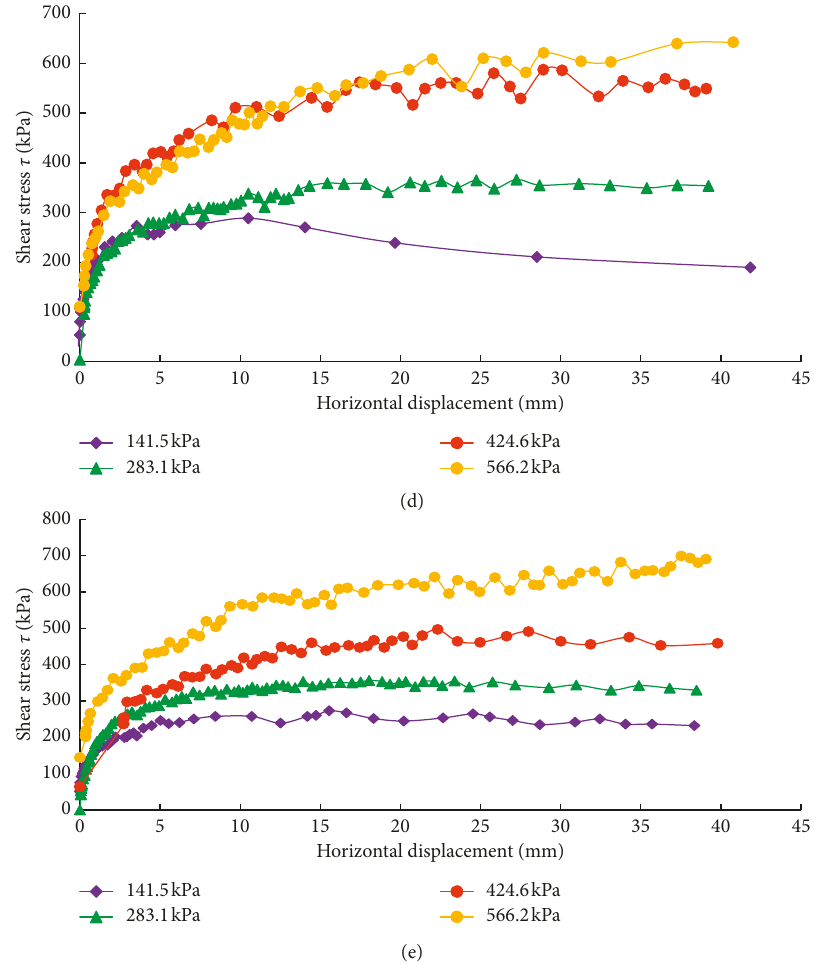
Figure 5: Shear stress and horizontal displacement curves of different rock particle content samples under the different normal stresses: (a) RPC � 35%; (b) RPC � 45%; (c) RPC � 35%; (d) RPC � 65%; (e) RPC �